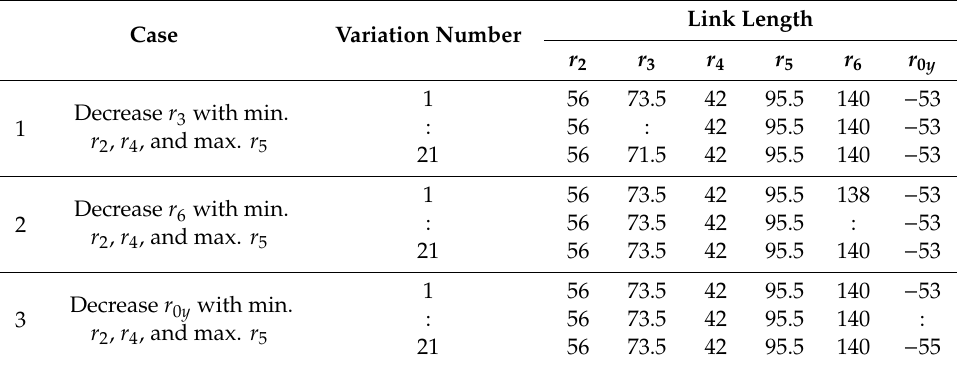
Figure 9. Adjusted stroke and maximum value of vertical second harmonic acceleration sum in each case: ( a ) adjusted stroke and ( b ) maximum vertical second harmonic acceleration sum in the in-line four-cylinder engine.